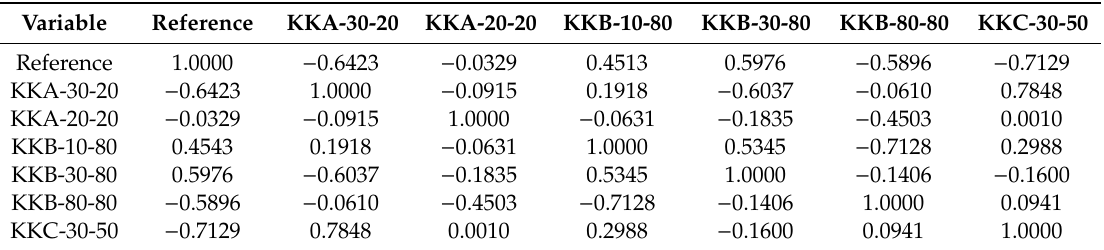
Table 8. The correlation coefficient of the tensile modulus obtained in various ageing variants and in the reference condition (for significance coefficient p < 0.05).